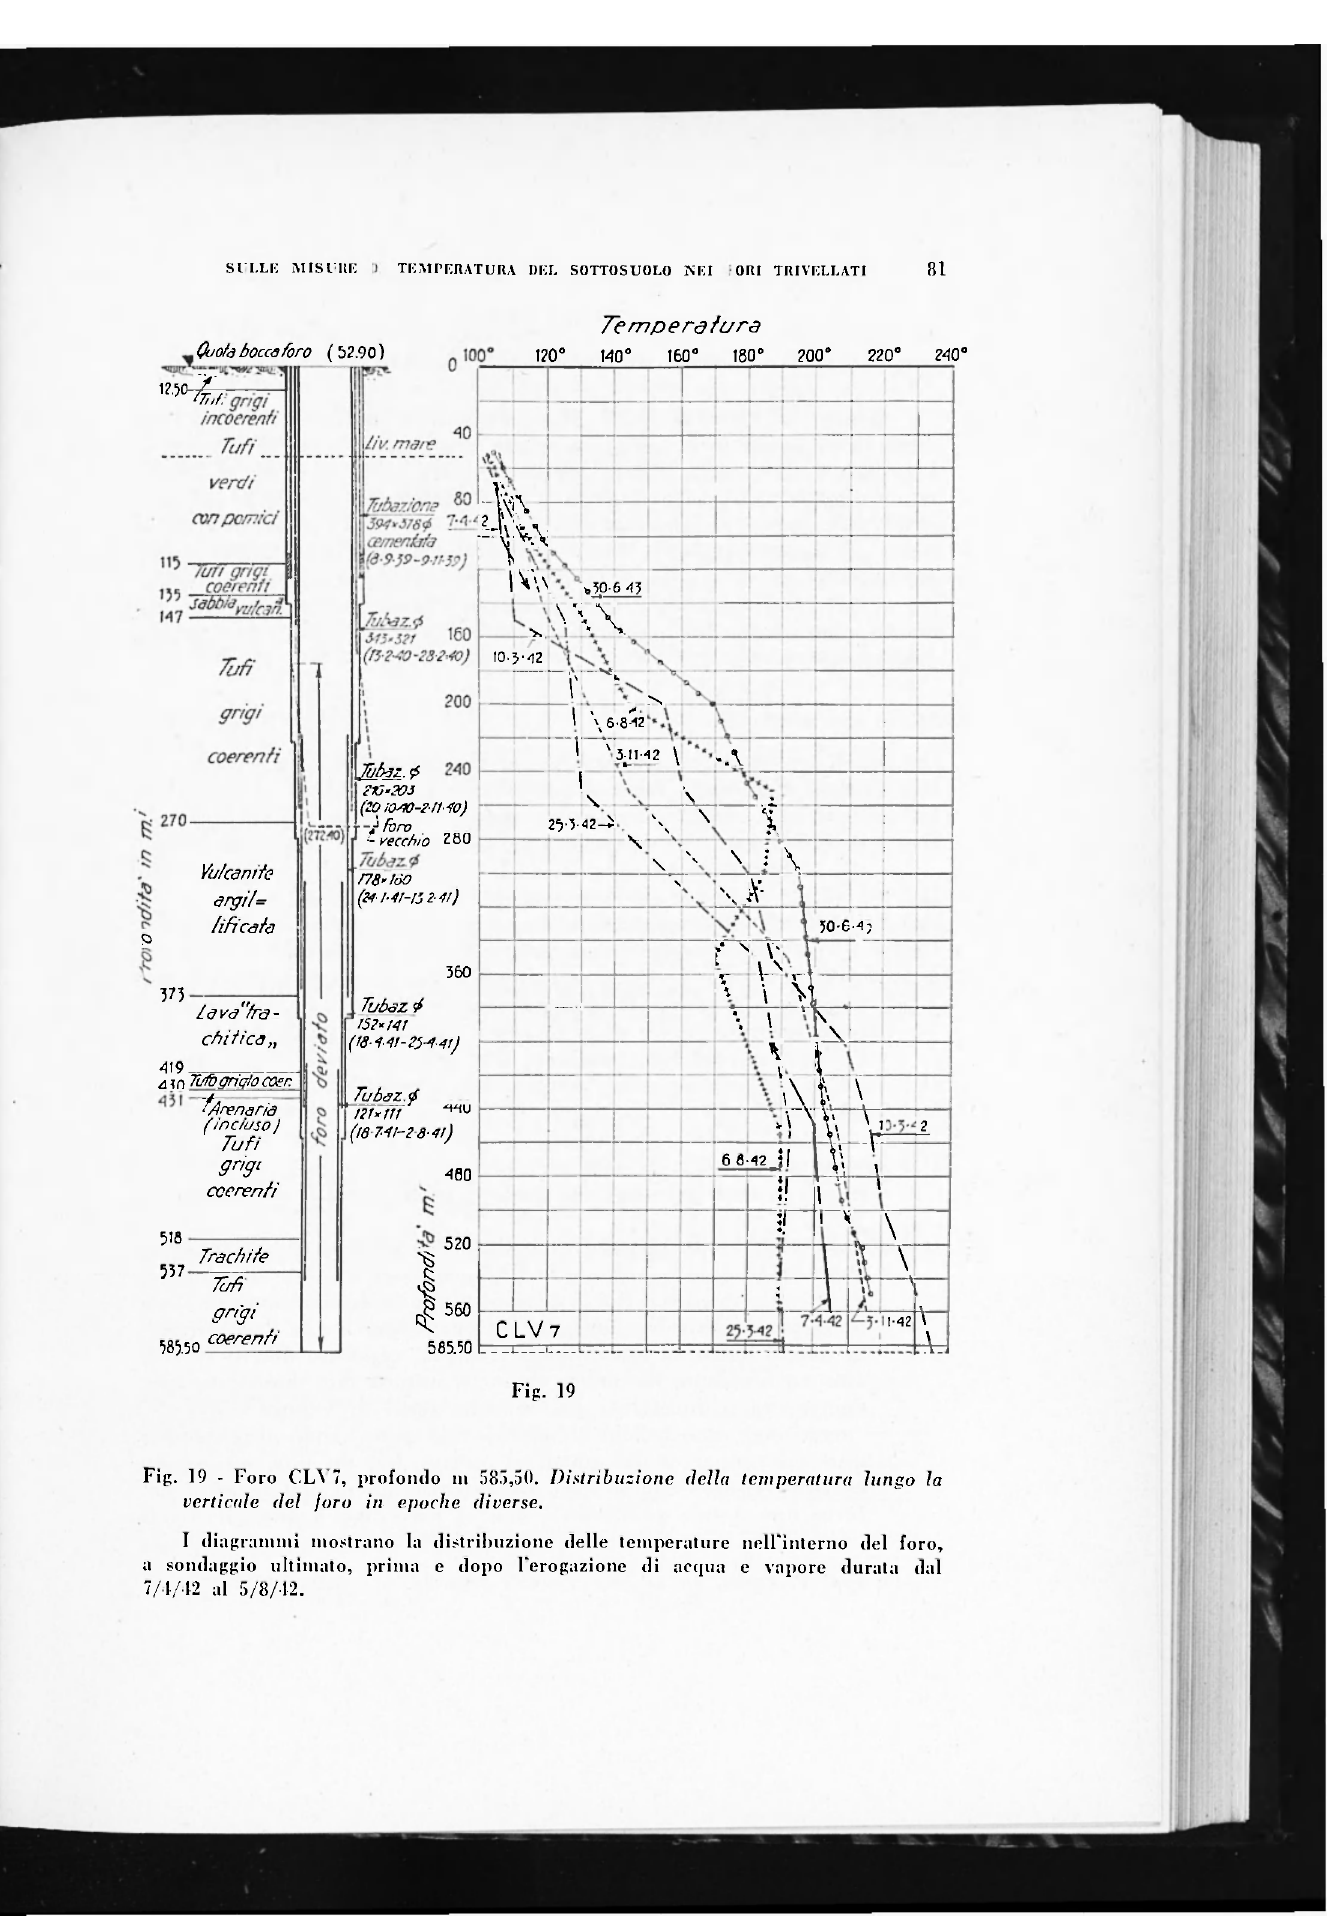
Fig. 19 - Foro CLY7, profondo m 585,50. Distribuzione della temperatura lungo la verticale del foro in epoche